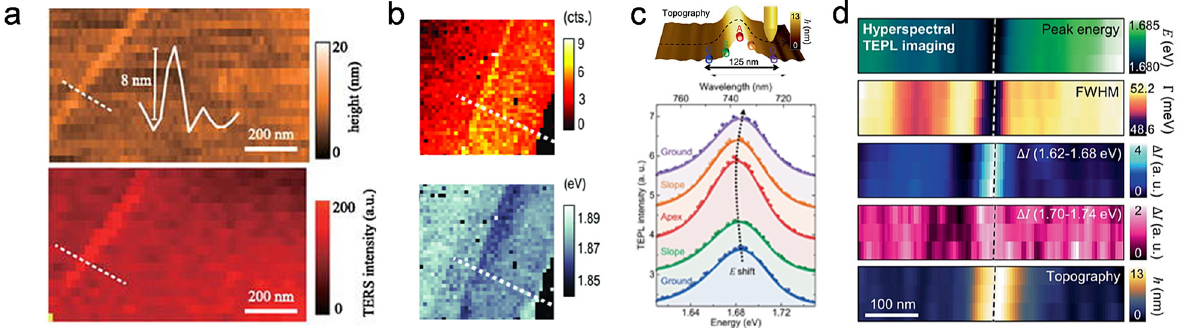
Figure 8: Near-field optical images of wrinkles in 1L-TMDs. (a) AFM image (upper panel) and TERS intensity image (lower panel) of 1L-MoS 2 . Reproduced with permission from ref. [76]. Copyright 2019, American Institute of Physics. (b) TEPL intensity image (upper panel) and peak energy image (lower panel) of 1L-MoS 2 . Reproduced with permissionfromref.[116].Copyright2019,WILEY-VCH.(c)TopographyofawrinkleinWSe 2 (upperpanel)andTEPLspectraobtainedatwrinkle (lower panel). (d) TEPL images of peak energy, FWHM, intensity obtained at 1.62 – 1.68 eV and 1.70 – 1.74 eV, and topography image. Reproduced with permission from ref. [35]. Copyright 2021,